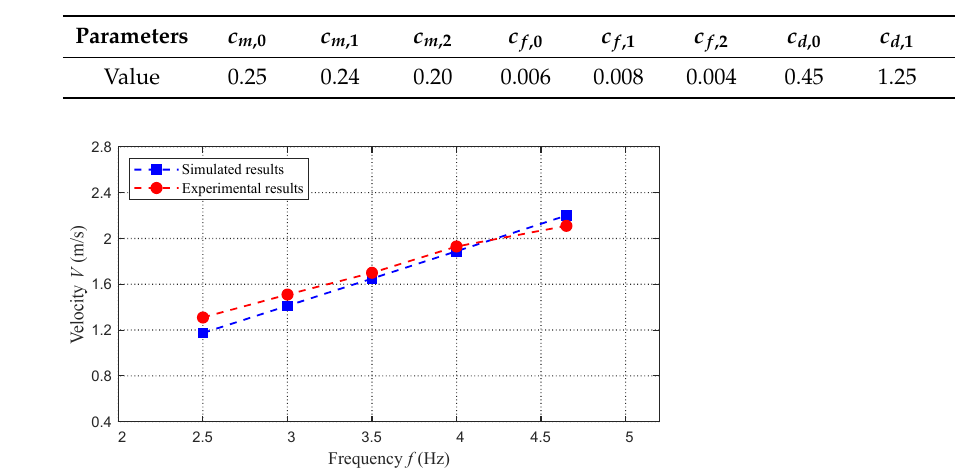
Table 3. Hydrodynamic parameters of the robotic dolphin.